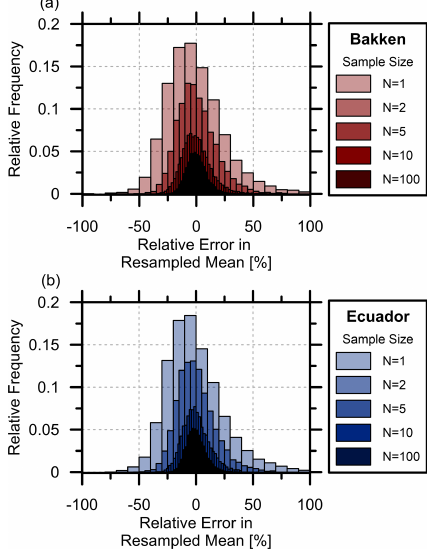
Figure 9. Distributions of sample mean for sample sets of size N from BC / H 2 O ratio results of the (a) Bakken and (b) Ecuador flare